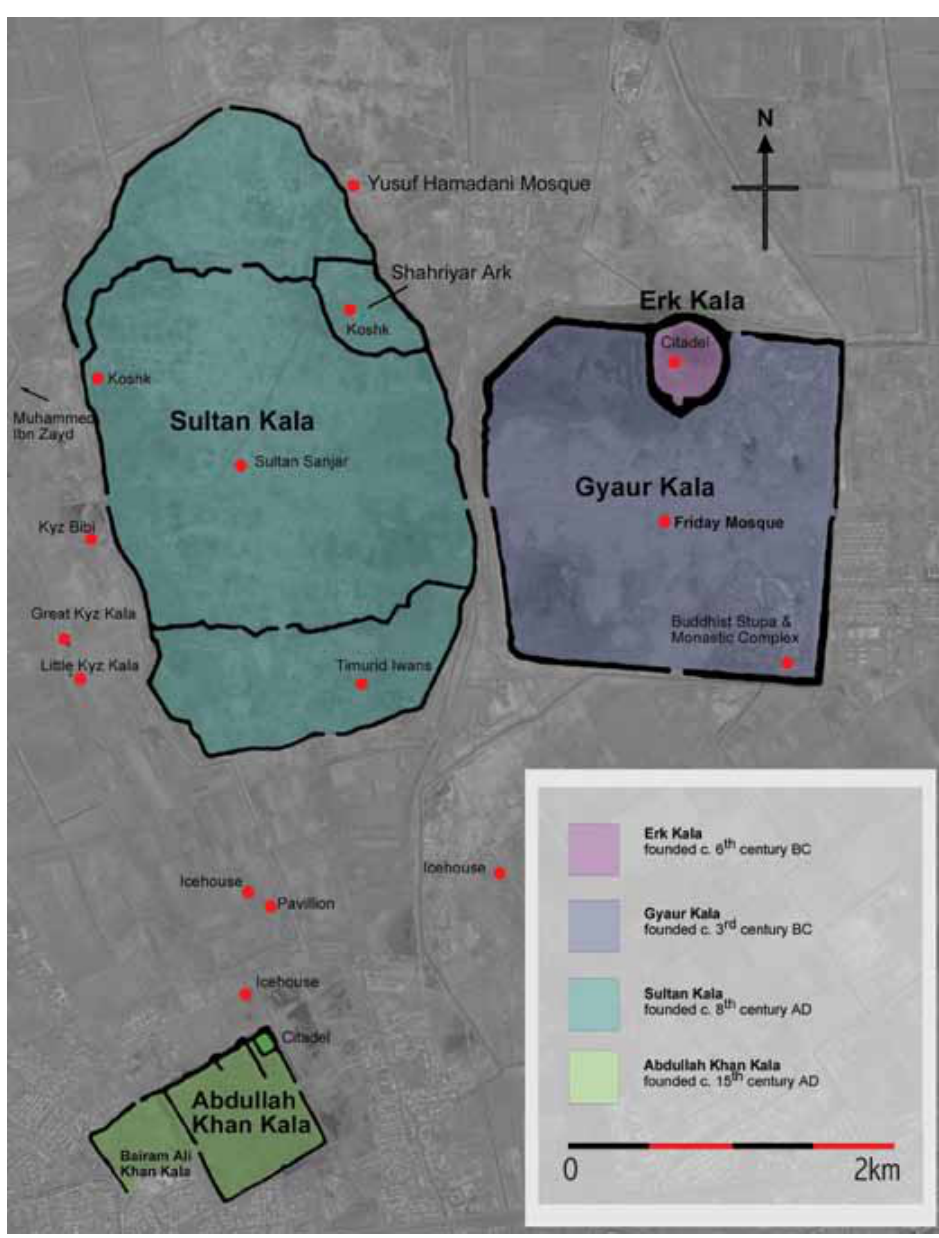
Fig. 1: The cities of Merv. The earliest, Erk Kala, was founded in the 6th century BCE; in the 3rd century BCE it became the citadel for the larger Hellenistic city of Antiochia Mar- ginana (today known as Gyaur Kala). Around the 8th century CE the new city of Sultan Kala was built to the west, with Gyaur Kala becoming an industrial suburb. In the 15th century the Timurid city of Abdullah Khan Kala was constructed to the south, with the walled extension Bairam Ali Khan Kala added in the 18th